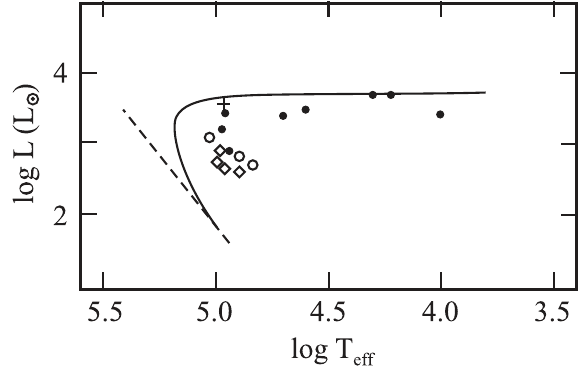
Fig. 7. Evolution of the hot component of the symbiotic nova AG Peg in the HR dia- gram based on the data from Kenyon et al. (1993) (dots), Kenyon et al. (2001) (circles), and this work (diamonds and a cross). The cross represents observations obtained during the outburst of